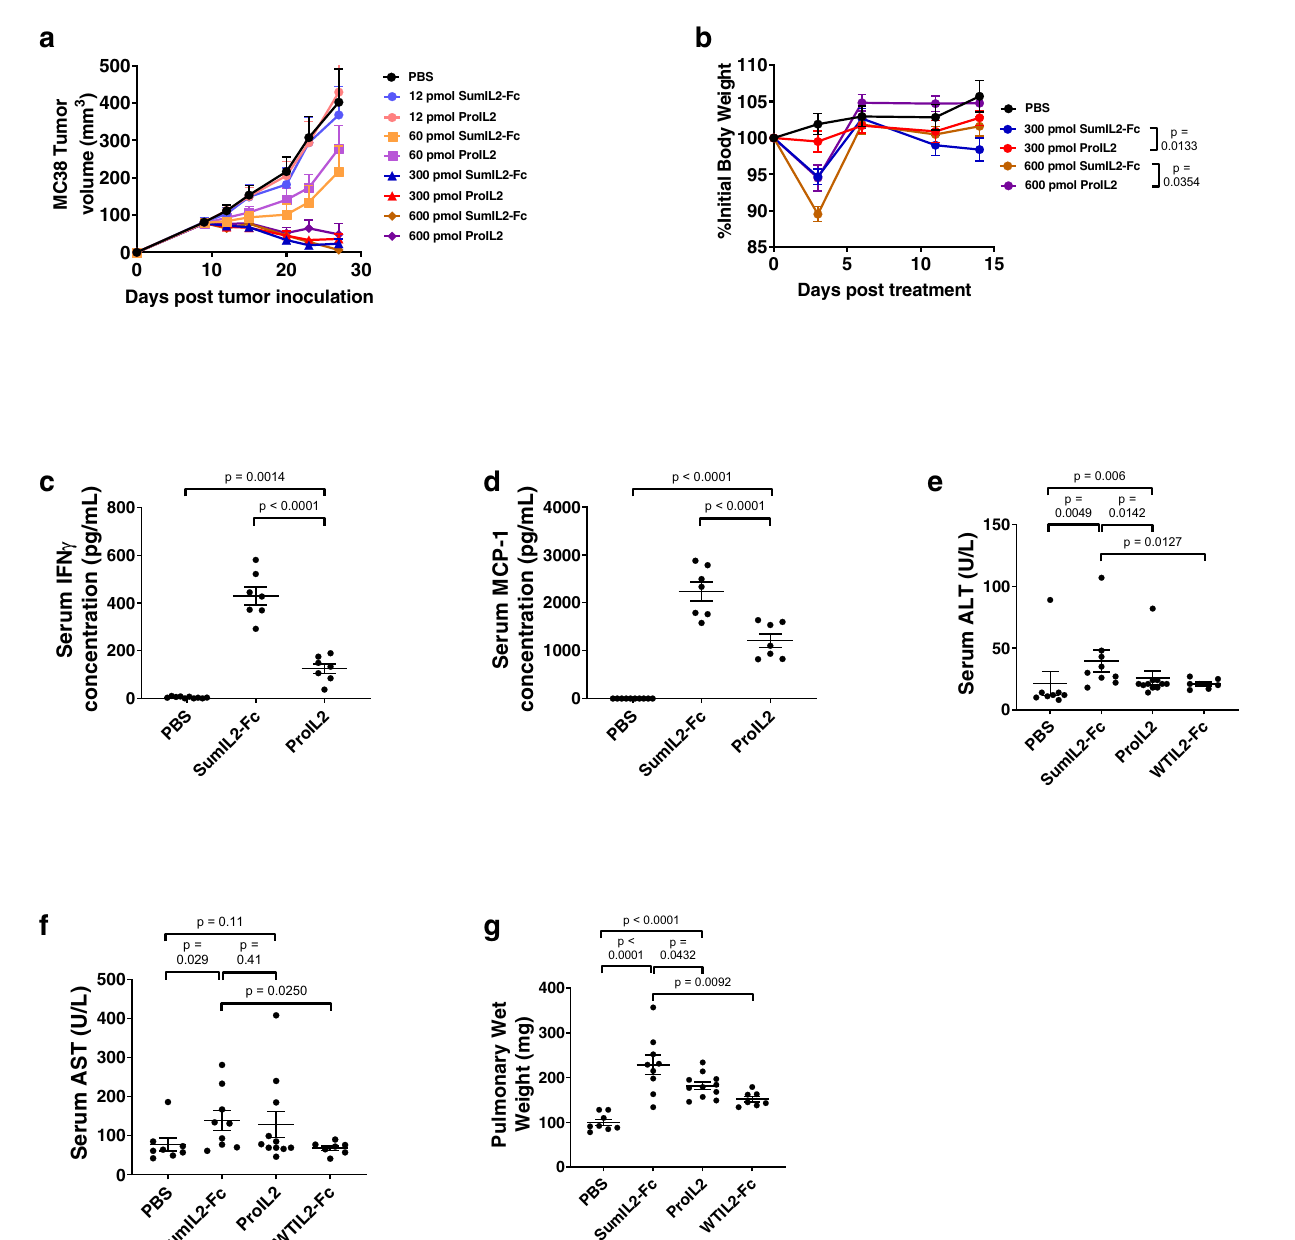
Fig. 4 In vivo antitumor ef fi cacy and toxicity assessment of ProIL2. a , b MC38 s.c. tumor-bearing mice were injected i.p. with one dose of the labeled treatment on day 9 post tumor inoculation; tumor growth and body weight were measured ( n = 2 experiments, total 6 individual mice for 12 pmol treatment groups, 7 for 600 pmol treatment groups, 8 for 60 and 300 pmol treatment groups). c , d B16 s.c. tumor-bearing mice were injected i.p. with PBS, SumIL2-Fc or ProIL2 (120 pmol) one time on day 9 post tumor inoculation. Serum was collected and isolated from mice 24 h post treatment, and Cytometric Bead Array was used to quantify the amount of serum IFN or MCP-1 ( n = 2 experiments, total 10 individual mice for PBS treatment group, 7 for other groups). e – g B16 s.c. tumor-bearing mice were injected i.p. with PBS, SumIL2-Fc, ProIL2, or WTIL2-Fc (150 pmol) two times on days 9 and 12